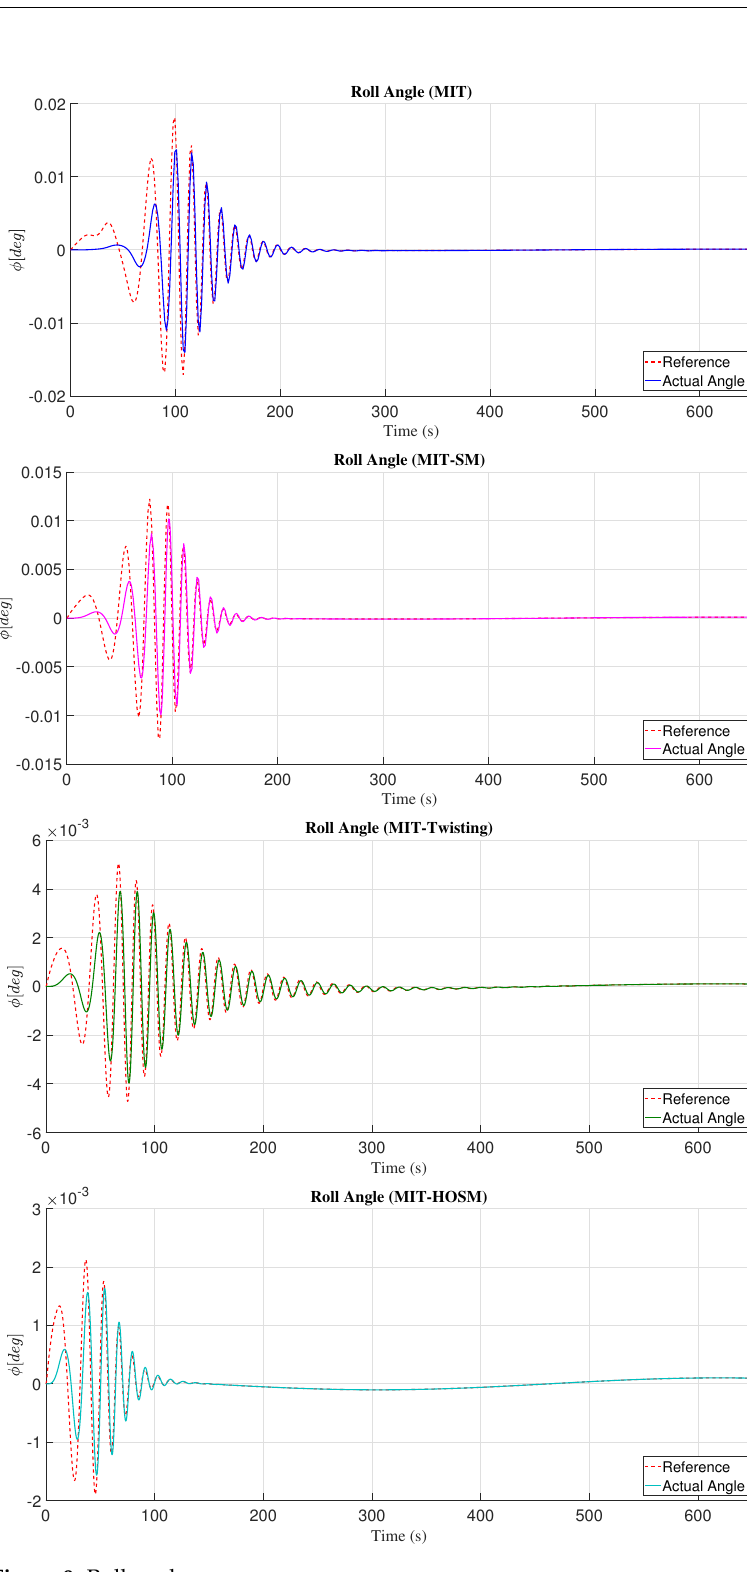
Figure 9. Roll angle